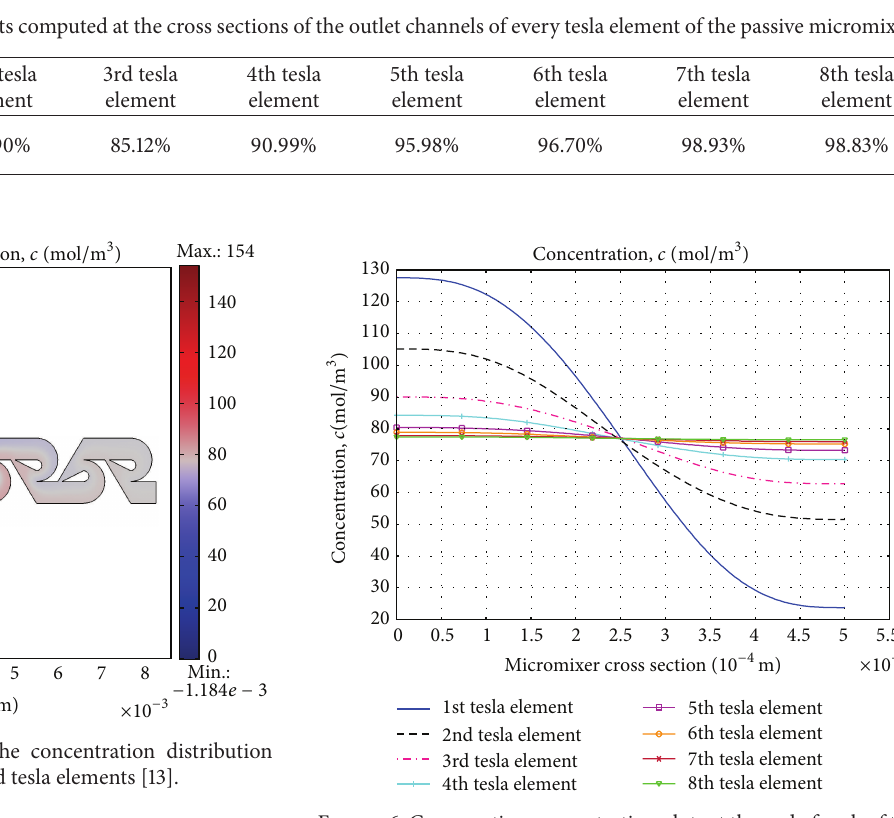
Figure 6: Cross section concentration plots at the end of each of the 8 connected tesla elements of the